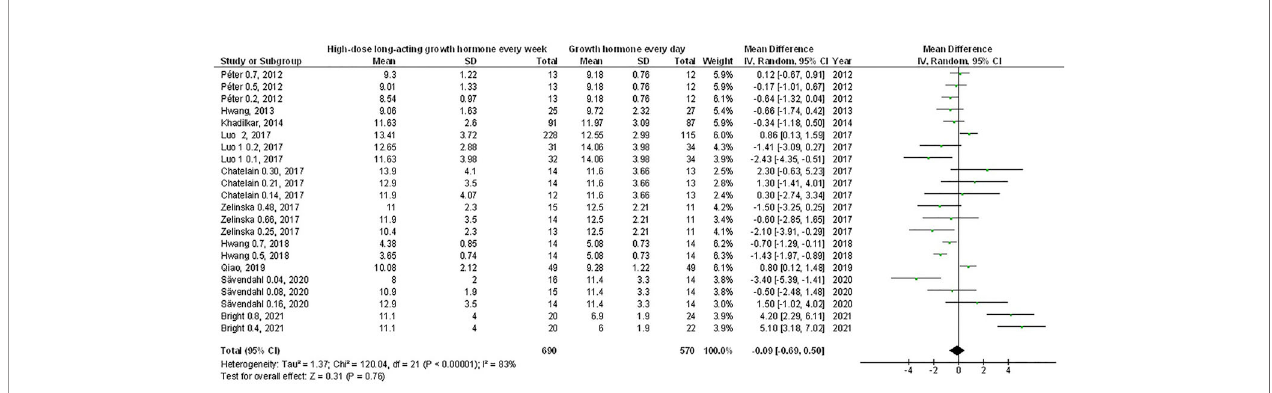
FIGURE 2 | Forest plot of the change in height velocity in long-acting growth hormone replacement therapy compared to daily growth